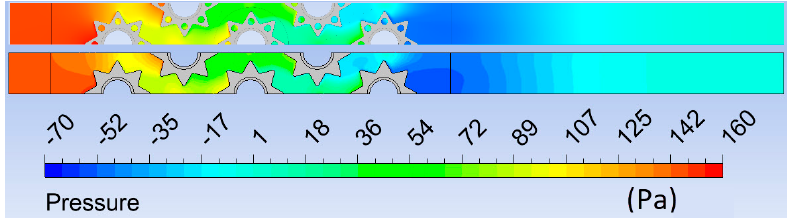
Figure 5. Pressure fields for perforated and non-perforated